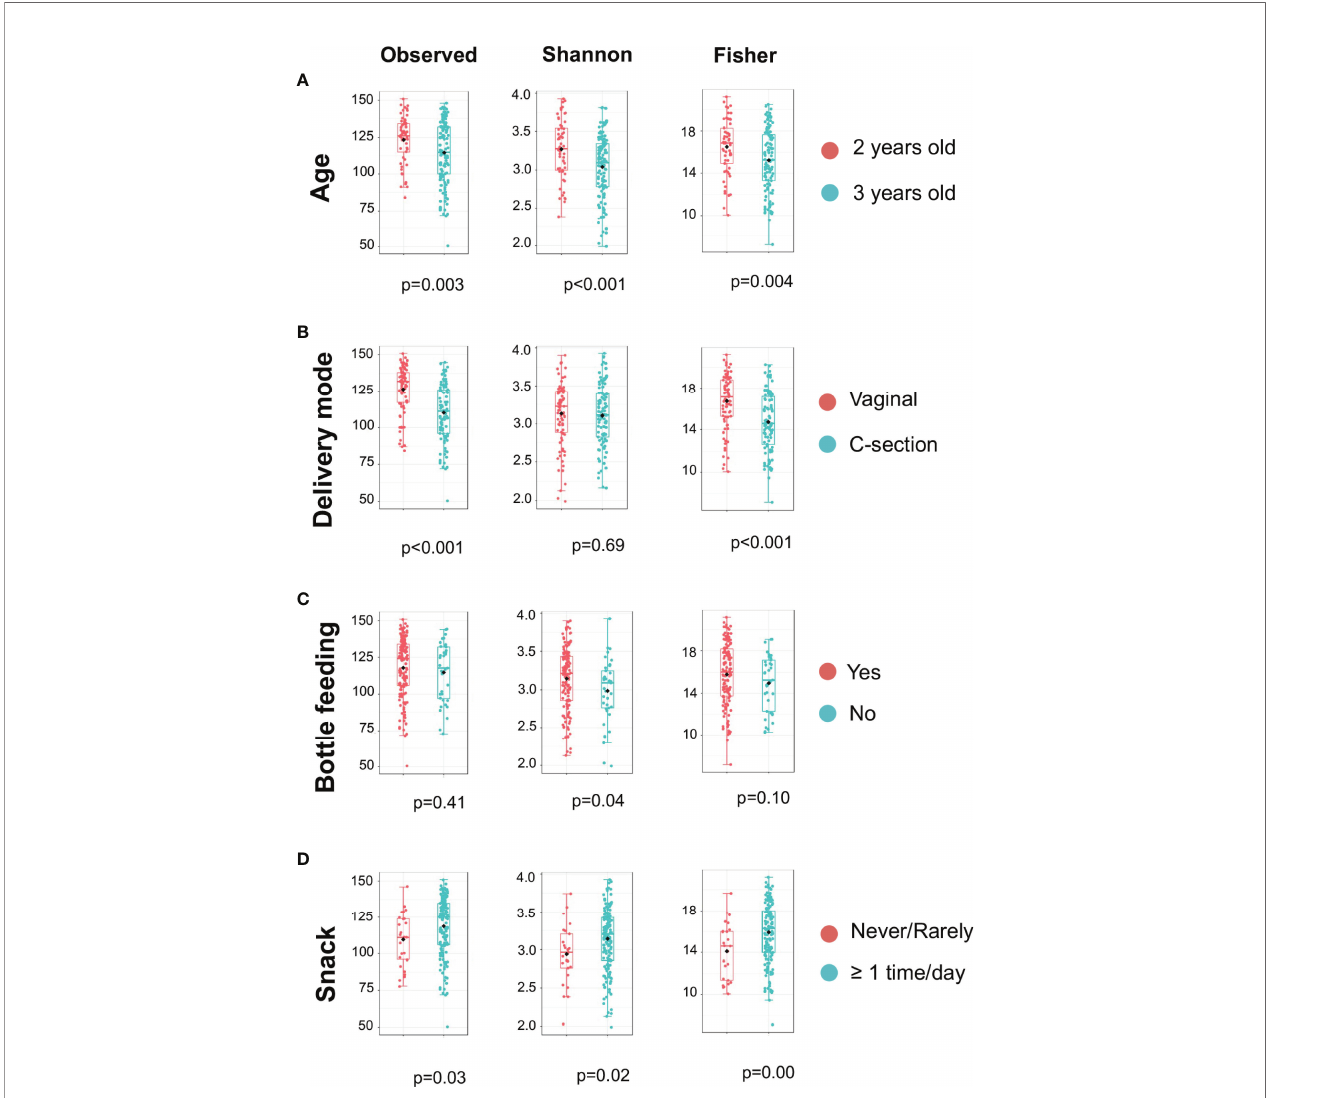
FIGURE 1 | Alpha Diversity of salivary microbiome among children. Microbial variation measured by alpha diversity index among children from different age group (A) , mode of delivery (B) , Bottle feeding (C) , and Consumption of snacks (D) . T-test was used for the statistical